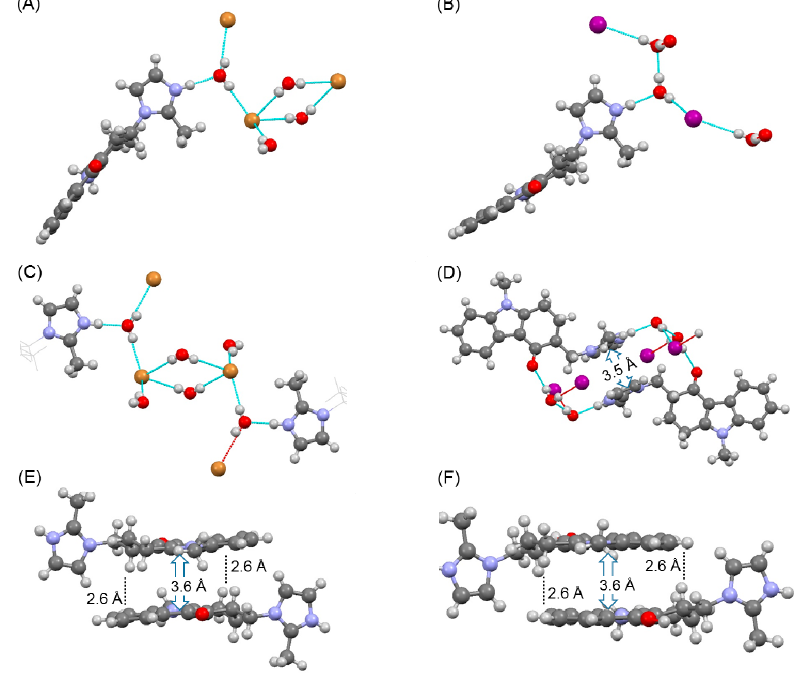
Figure 1. Results of single crystal structure analysis of the hydrogen bonding network in the ( A , C ) HBr salt, and ( B , D ) HI salt, and π - π stacking interactions in the ( E ) HBr salt and ( D , F ) HI salt. Single crystal structure analysis confirmed that ondansetron HBr formed a dihydrate.